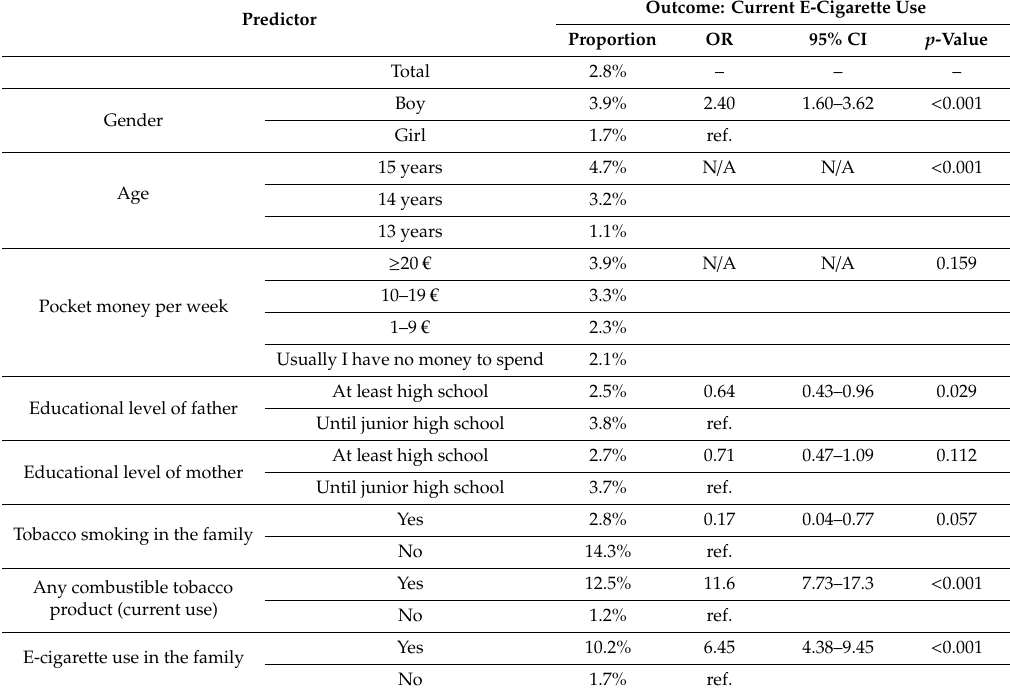
Table 3. Bivariate analysis of current e-cigarette use (all